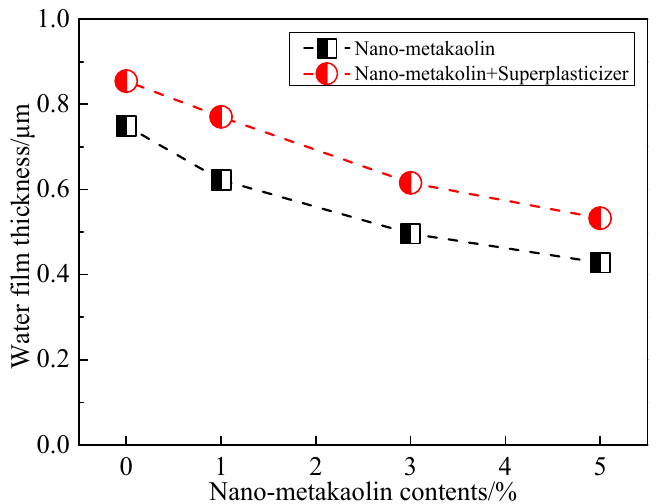
Figure 6. Effects of nano-metakaolin and superplasticizer on cementitious particles of cement pastes [11].